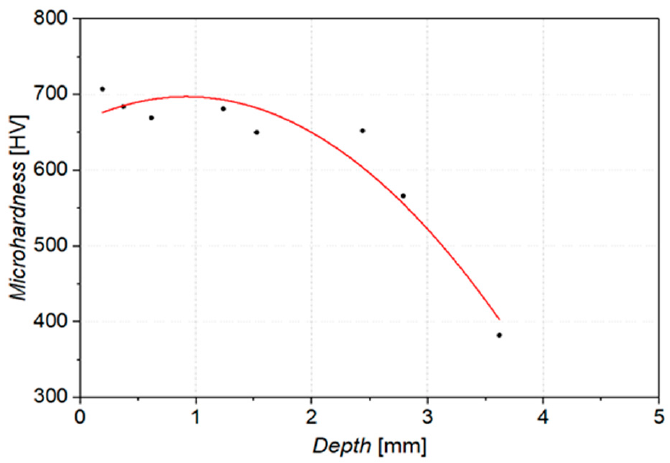
Figure 7. Dependence of microhardness as a function of